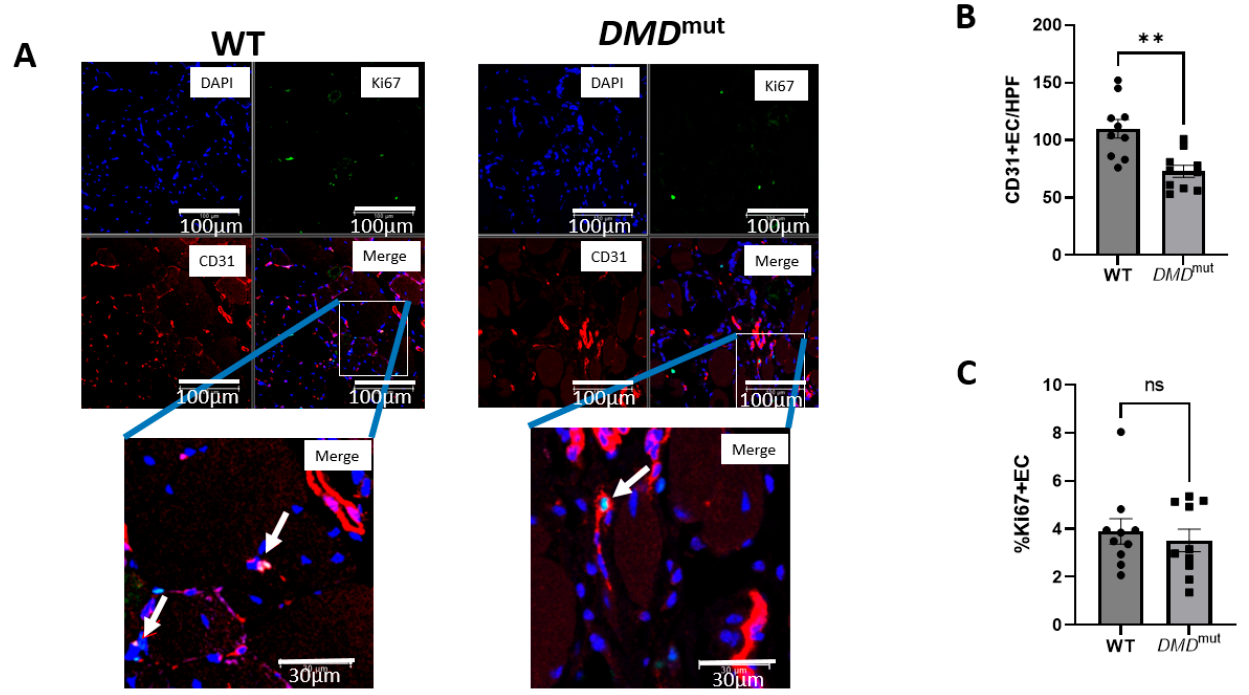
Figure 5. The effect of DMD mutation on the density and proliferation of endothelial cells in DMD mut muscles compared to control muscles. ( A ) Immunofluorescent staining of CD31 and Ki67 was performed to detect EC density and cell proliferation in TA muscles from DMD mut and wide-type control mice. The regions of interest (white squares) were cropped from images (Upper). The CD31/Ki67-double positive cells were indicated with arrows. ( B ) The comparison of CD31-positive cells per high power field (HPF) between TA muscles from DMD mut and control mice (**, p < 0.01, n = 10). ( C ) The comparison of the percentage of Ki67-positive EC cells between TA muscles from DMD mut and wide-type control mice (ns, n = 10).